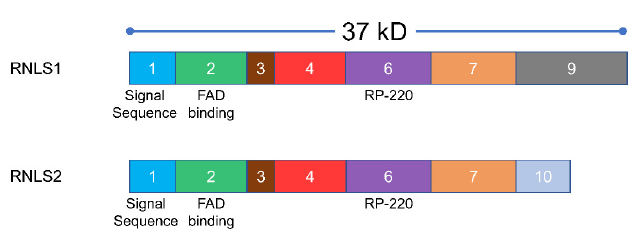
Figure 1. Renalase domains are conserved between RNLS1 and RNLS2, which only differ in the C- terminal site because of differences in splicing. The RP-220 site has prosurvival activity; it is also target for an inhibitory RNLS